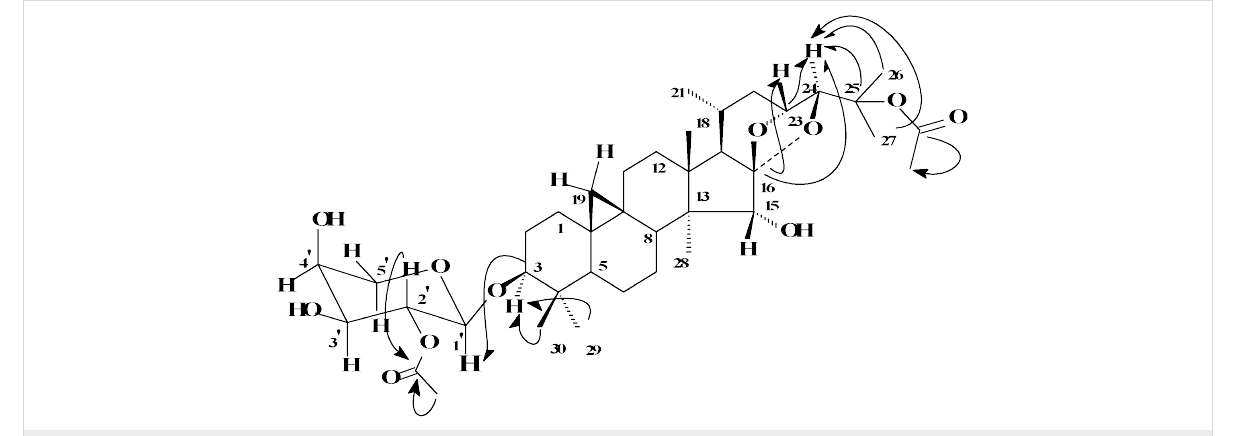
Figure 3: Key long-range 13 C- 1 H correlations of 2 observed by HMBC for the relevant carbons with the acetyl groups.